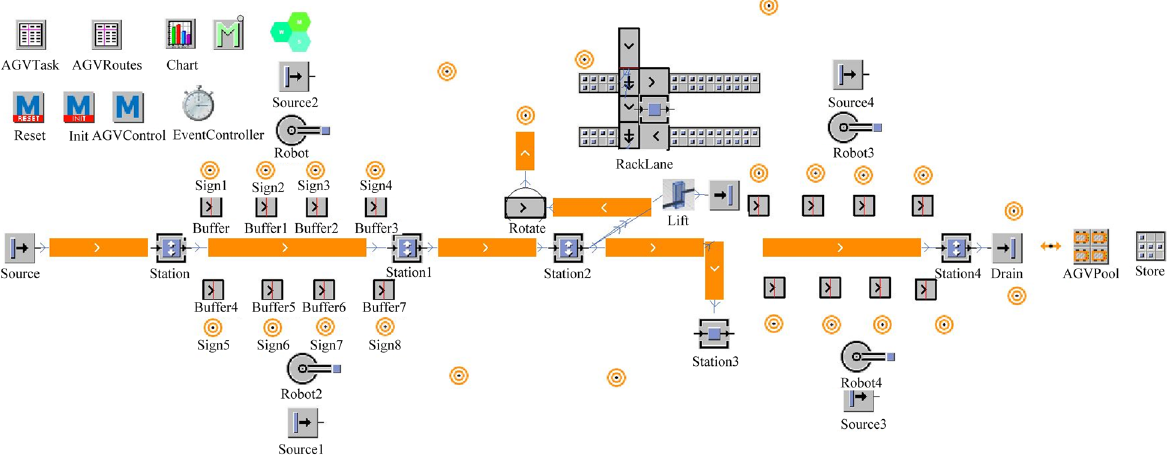
Fig. 3 Wagon dismantling system 2D object